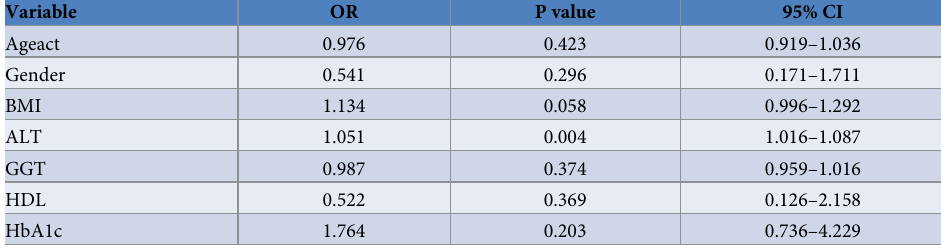
Table 4. Multiple logistic regression analysis of variables predicting moderate to severe steatosis on